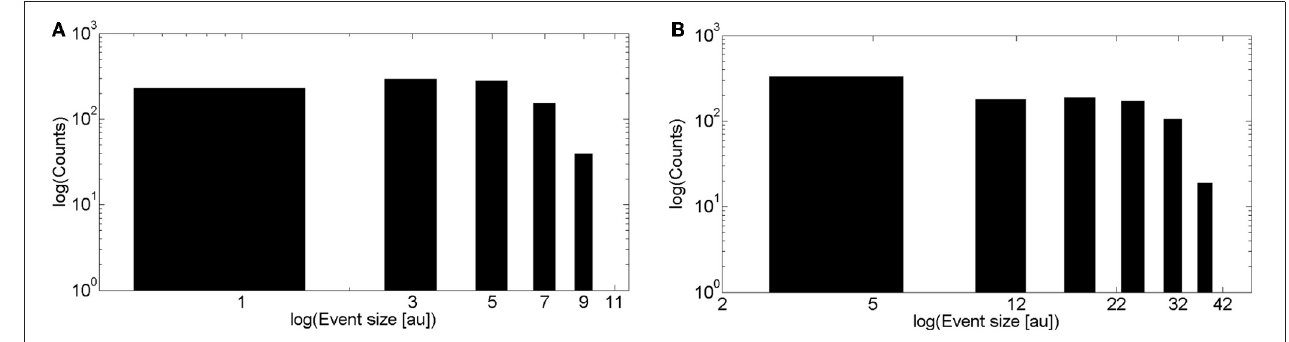
FIGURE 3 | Event size distributions obtained with simulations of the intra and intercluster models without Ca 2 + accumulation. (A) Distribution obtained with 1000 realizations of the intracluster (local) model